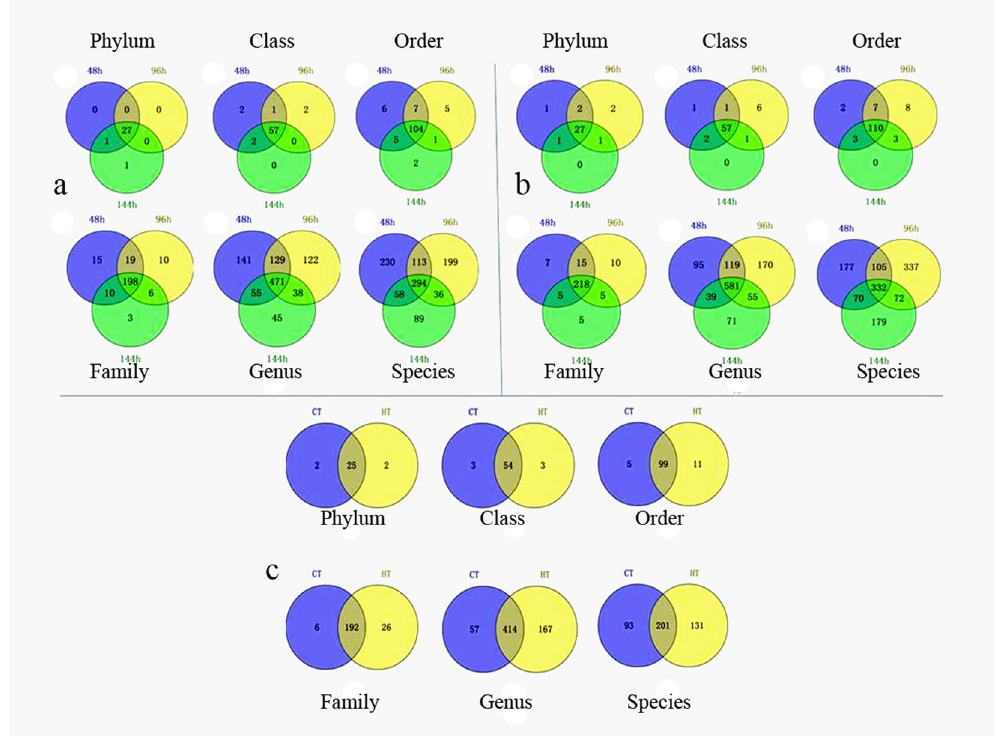
Figure 2. Shared bacterial types of different samples at different classification levels. ( a ) Venn analysis of the control silkworms at different time points; ( b ) Venn analysis of THTT silkworms at different time points; ( c ) Venn analysis of control and THTT silkworms. CT, control silkworms; HT, silkworms exposed to transient high temperature; 48, 96 and 144 h, silkworms exposed to transient high temperature followed by rearing at normal temperature for 48, 96 and 144 h, respectively.